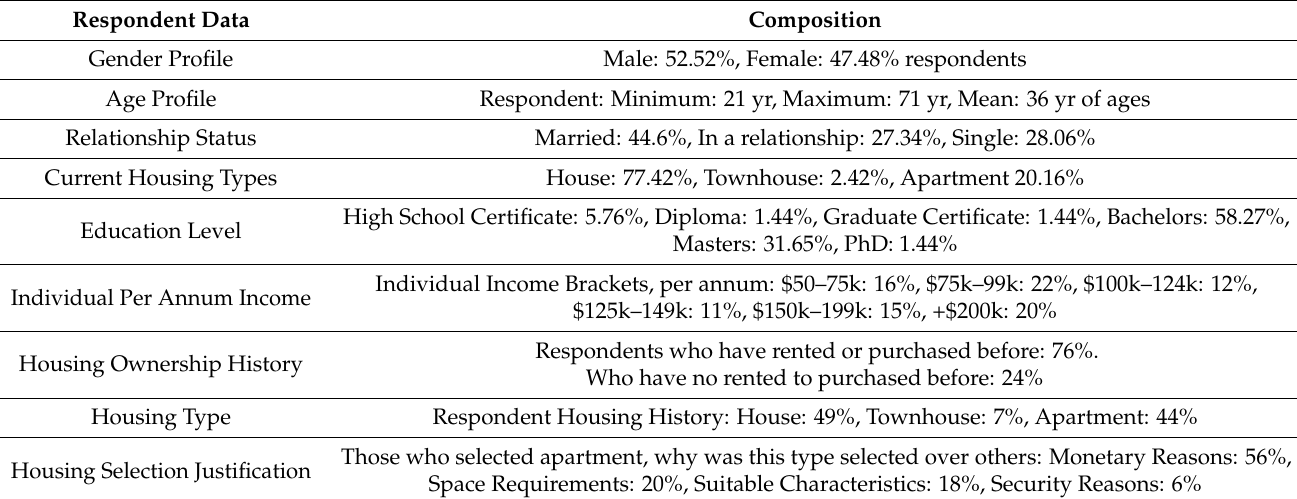
Table 1. Demographic Profile of